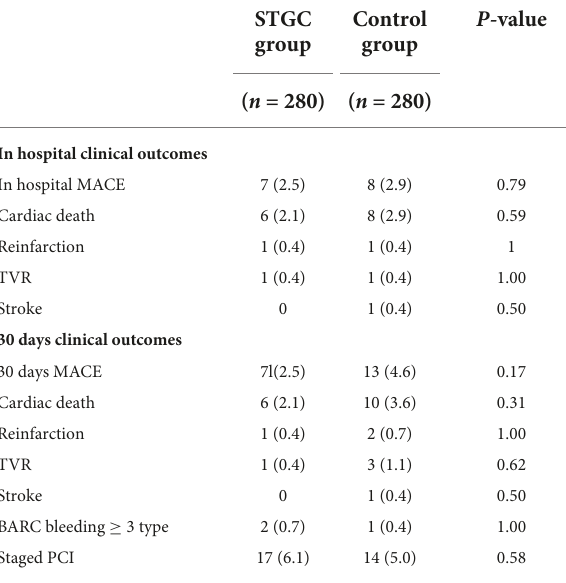
TABLE 4 Clinical outcomes.